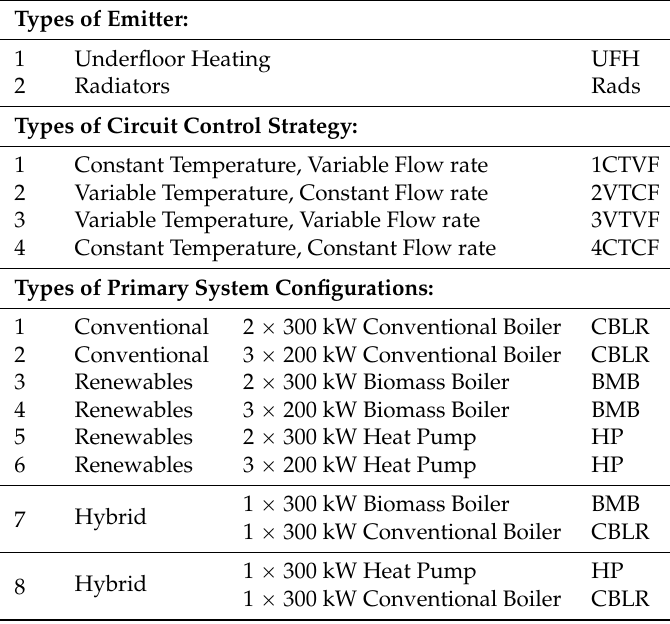
Table 3. Variants to be